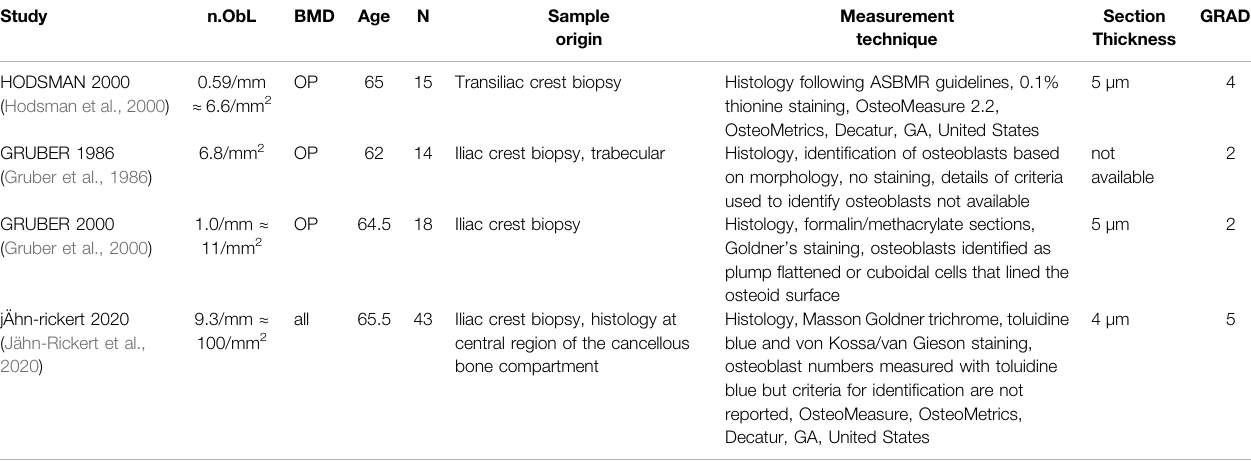
TABLE 9 | Osteoblast number measurements in postmenopausal women, in ascending